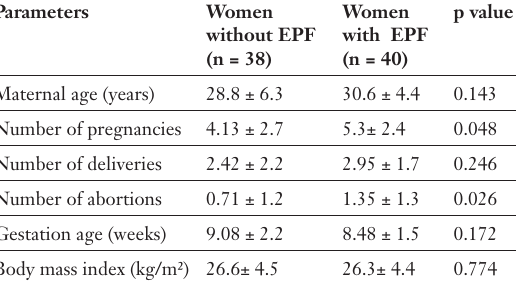
Table 1 Demographic parameters in women with and without